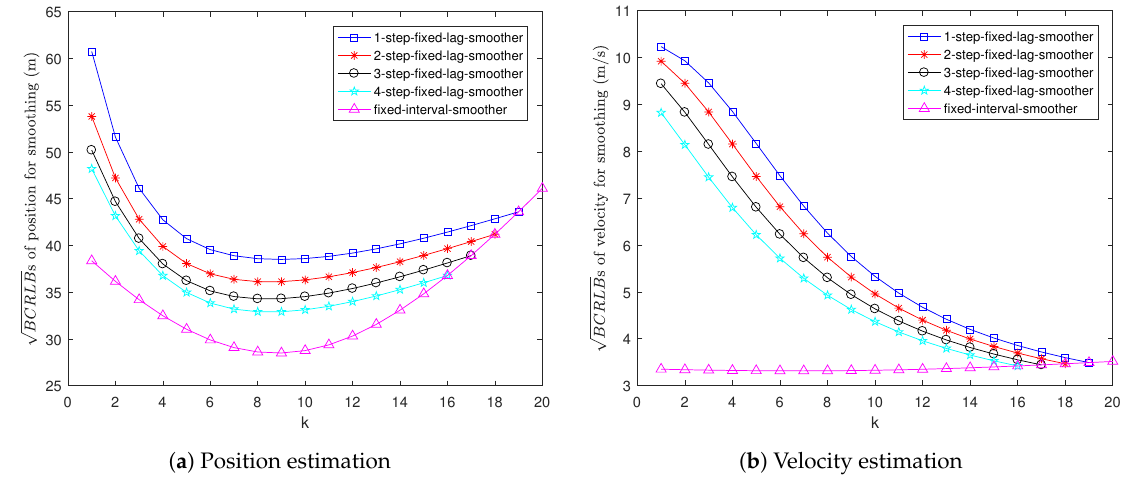
√ Figure 3. BCRLBs for smoothing in Example